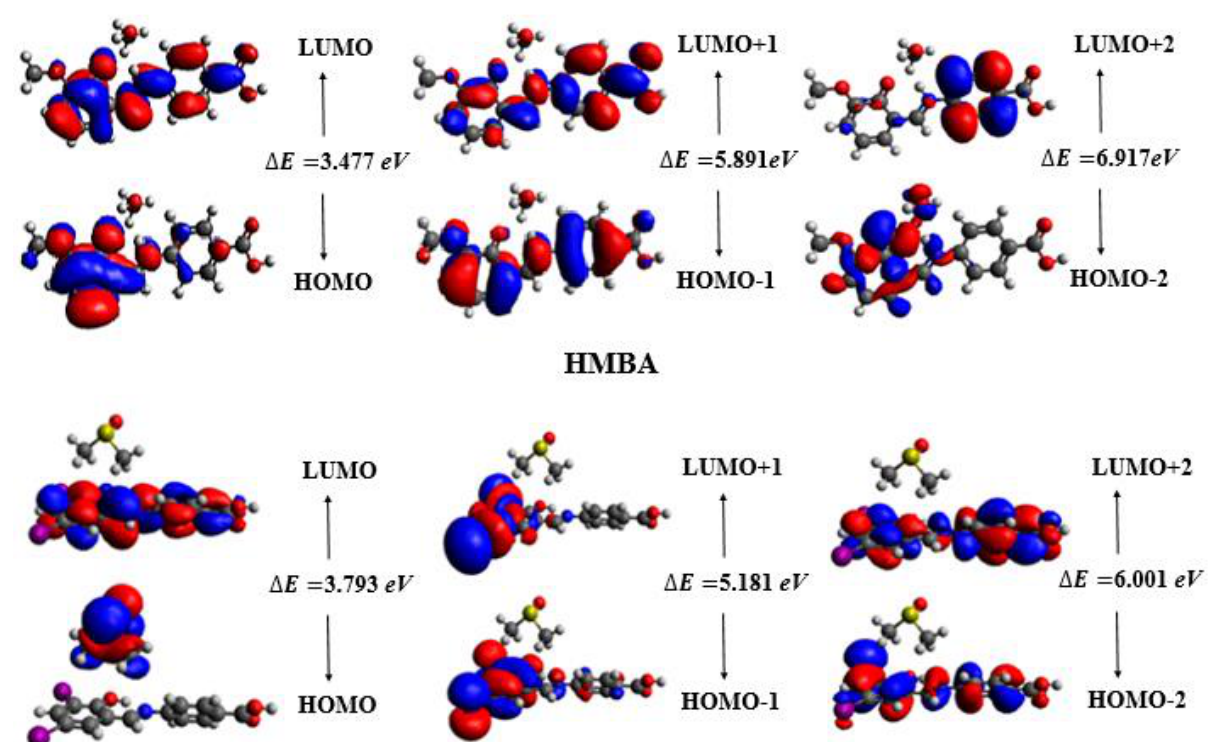
Figure 6. Frontier molecular orbitals HMBA and DHBA compounds.